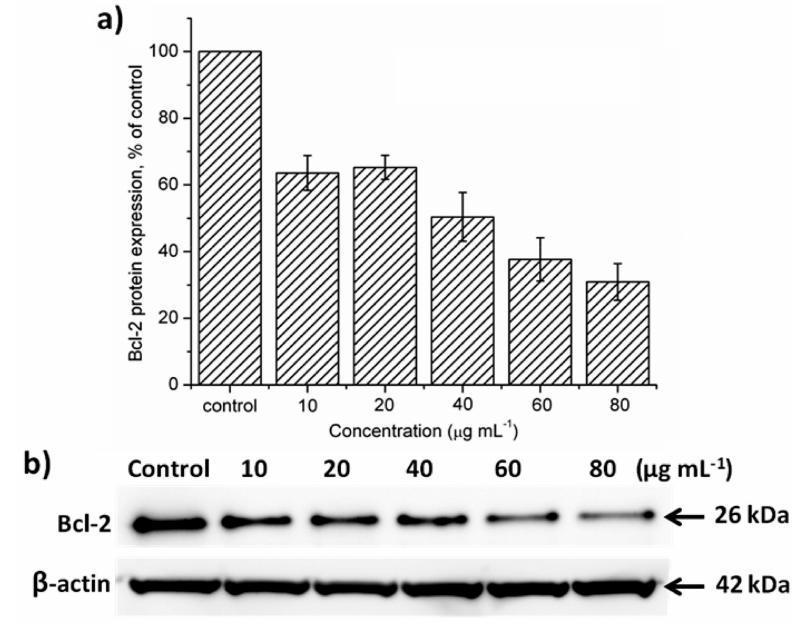
Figure 9. Analysis on protein expression levels of Bcl-2 after delivery of PNA into HeLa cells. ( a ) Quantitative analysis and ( b ) western blotting results of Bcl-2 protein expression levels. PNA/MSN, 1/20 ( w/w ). Adapted from reference [70] with